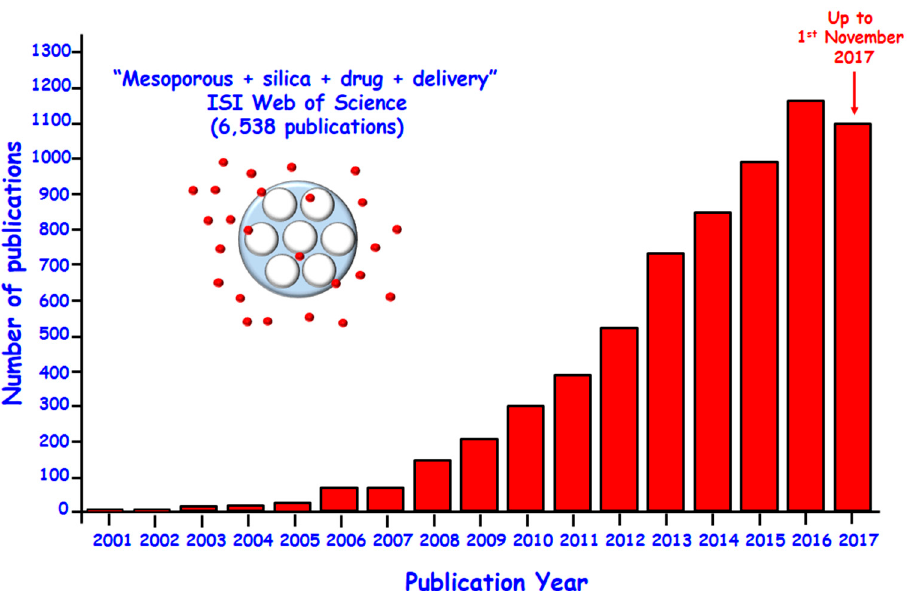
Figure 1. Number of publications per year indexed in the ISI Web of Science on the topic of “mesoporous” and “silica” and “drug” and “delivery” up to 1st November 2017.